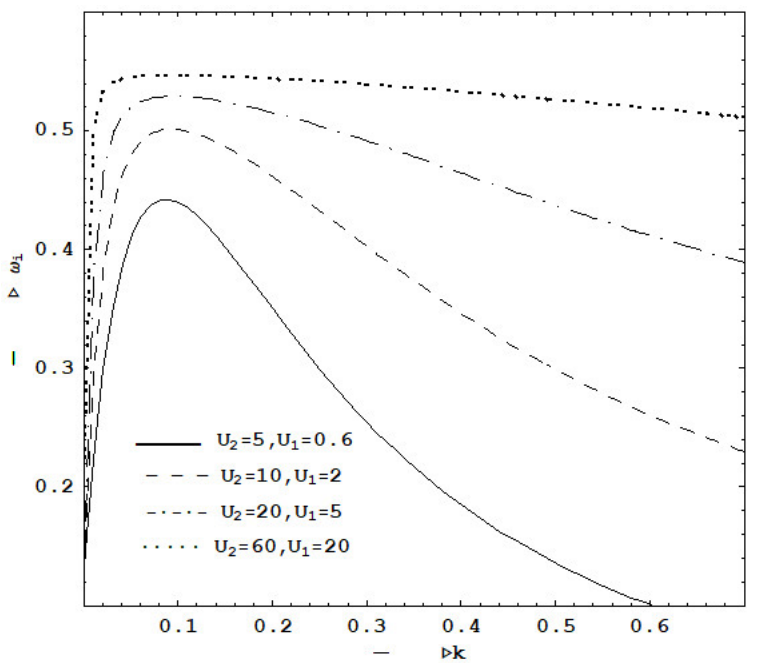
Figure 10. Variation of the growth rate ω i with the wavenumber k for different values of the fluid velocity U 1 , U 2 .